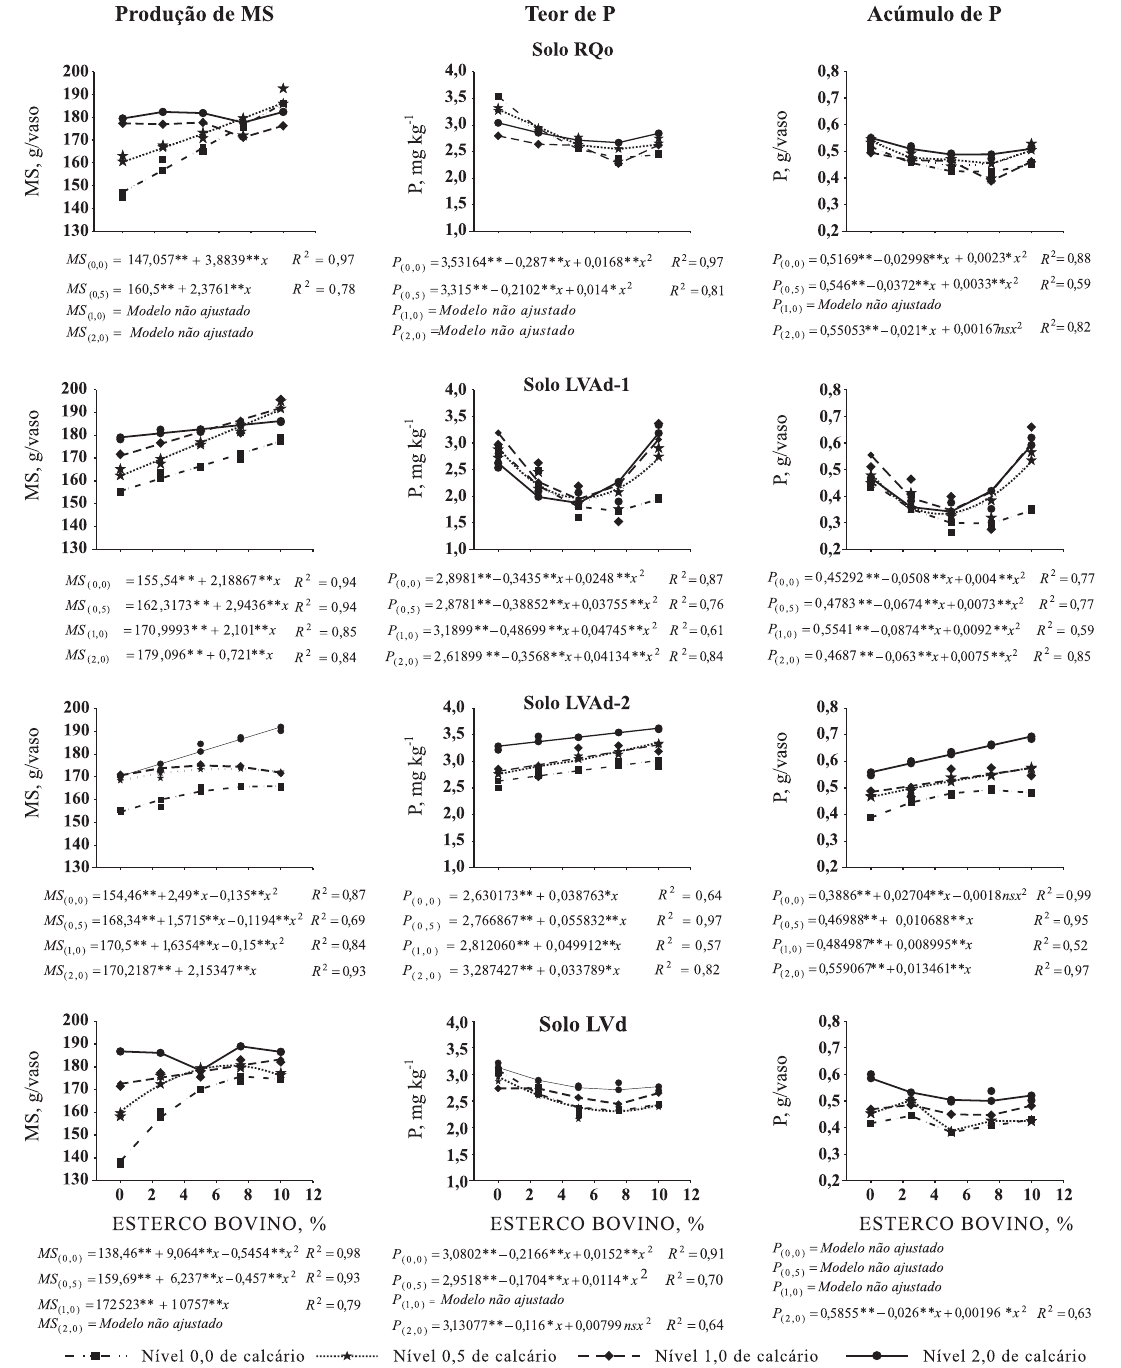
Figura 1. Produção de matéria seca (MS), teores e acúmulo de fósforo na MS da parte aérea do braquiarão, em função das doses de esterco bovino, em quatro doses de